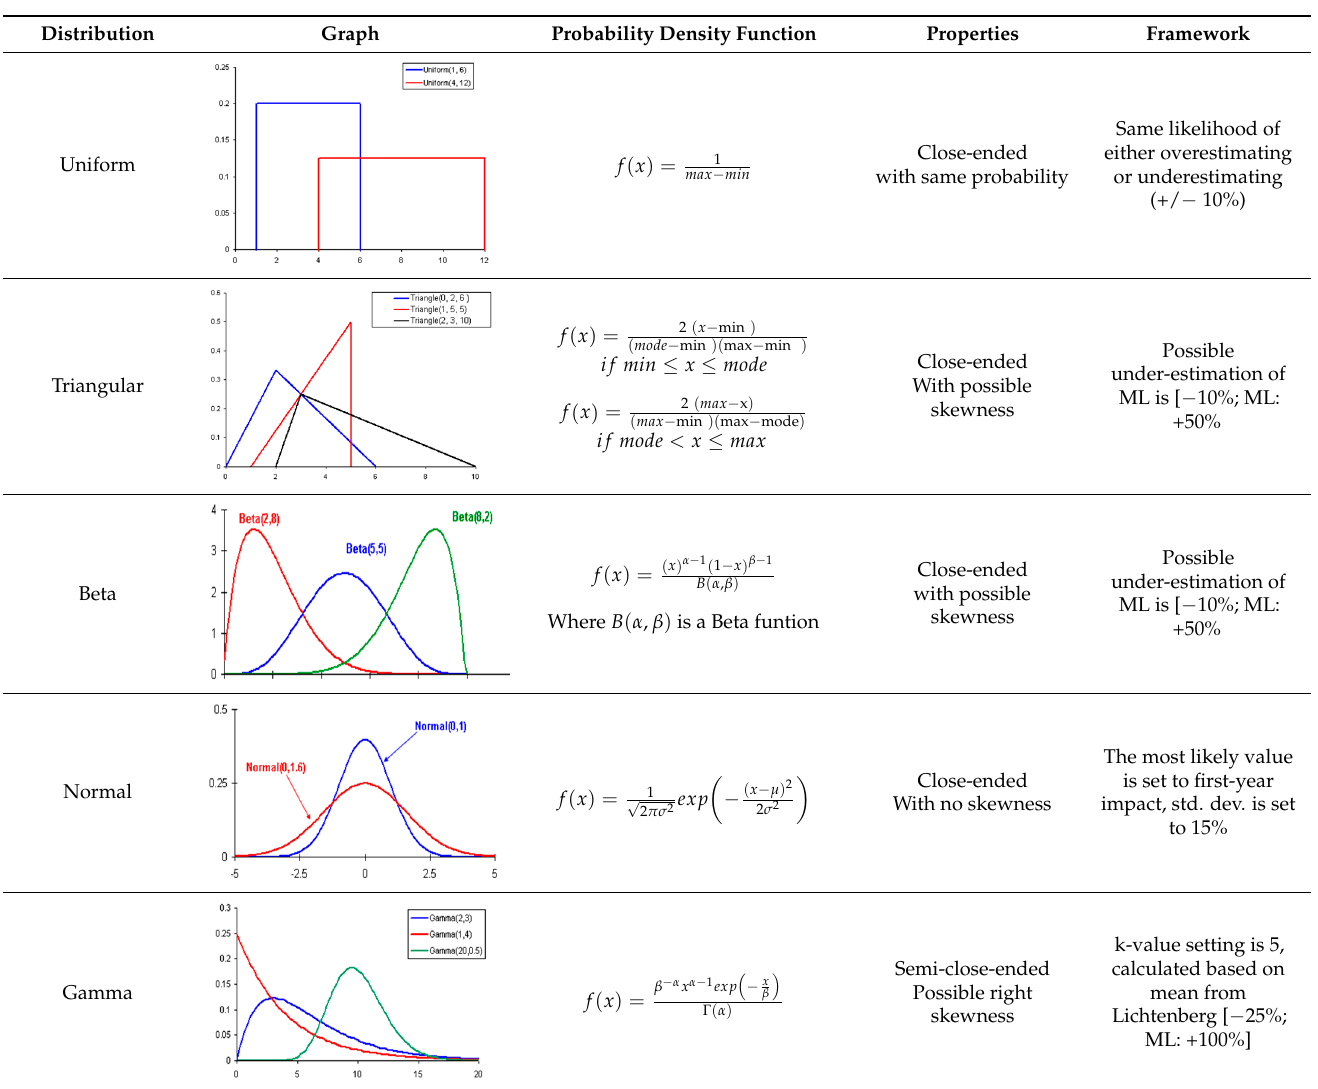
Table A5. Types of distributions.